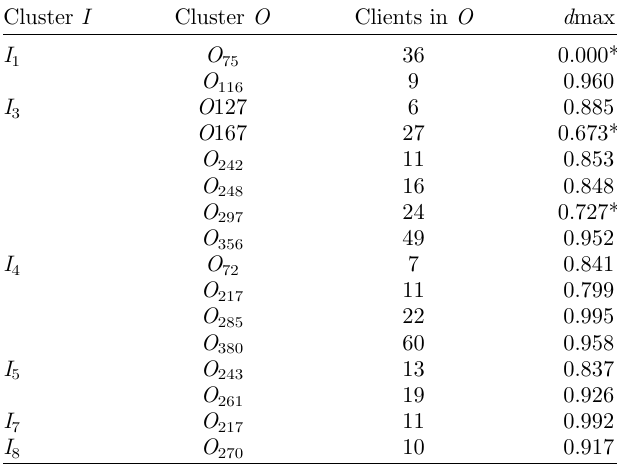
Table 9. For I i , i = 1, 3, 4, 5, 7, 8 are reported the clusters O j with d max < 1, see equation (4) and Remark 2. With * we indicate the highest risk cases.